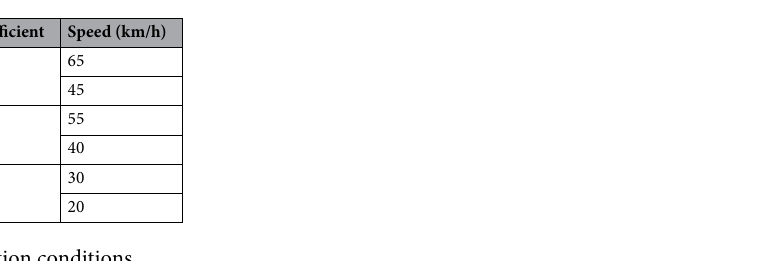
Table 2. DDAV simulation